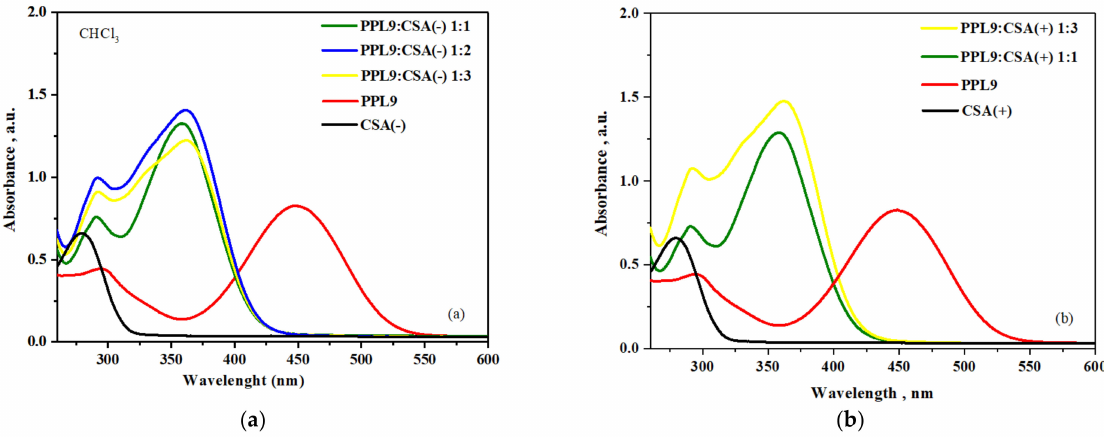
Figure 10. UV–vis study of PPL9 and their mixtures with CSA ( − ) ( a ) and CSA (+) ( b ).